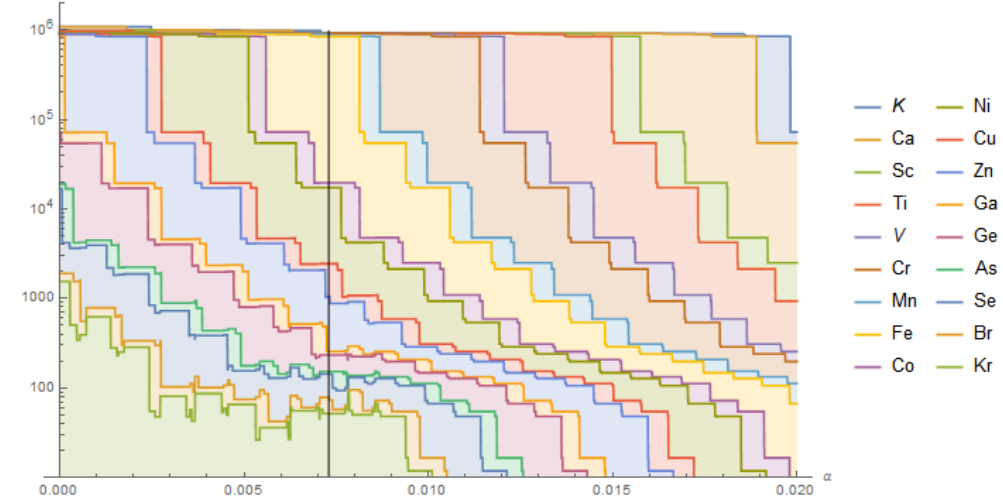
Figure 4. The abundances of the fourth row elements, restricted to the maximally sensitive direction in parameter space described in the text, and parameterized by α . The black line denotes our observed values. The elements are ordered from the upper right